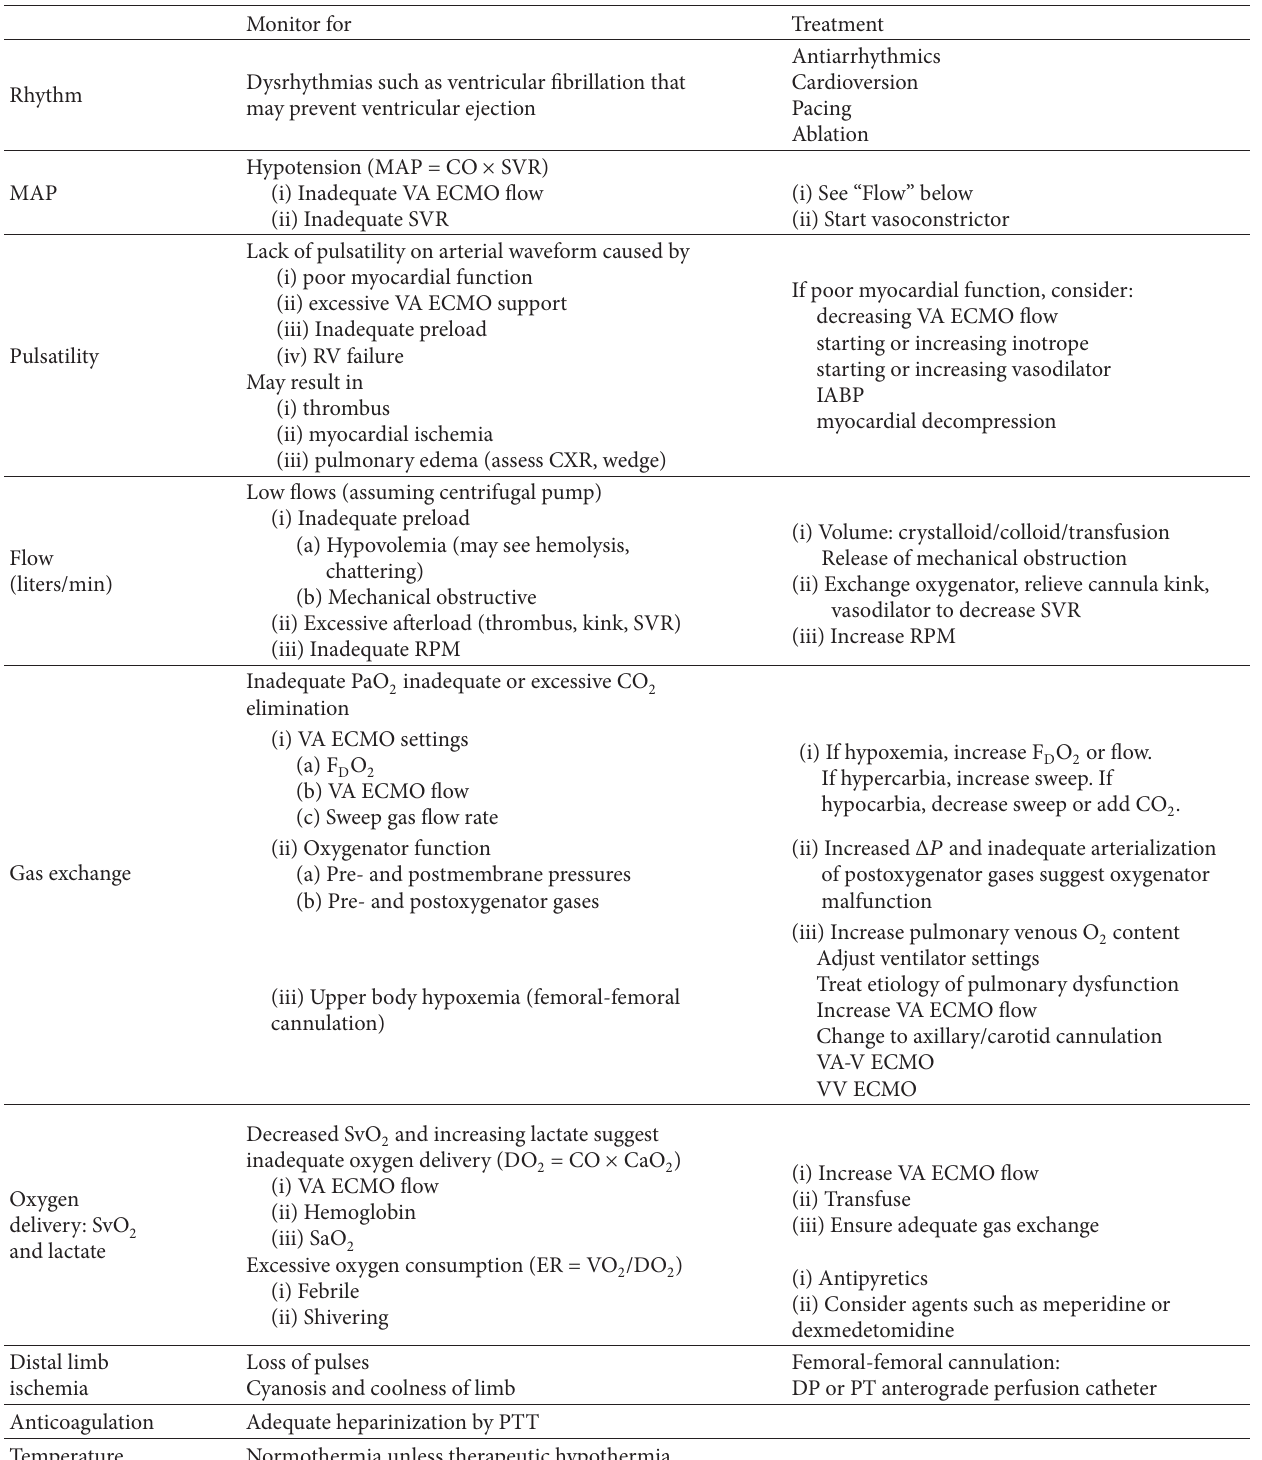
Table 5: Summary of monitoring in VA